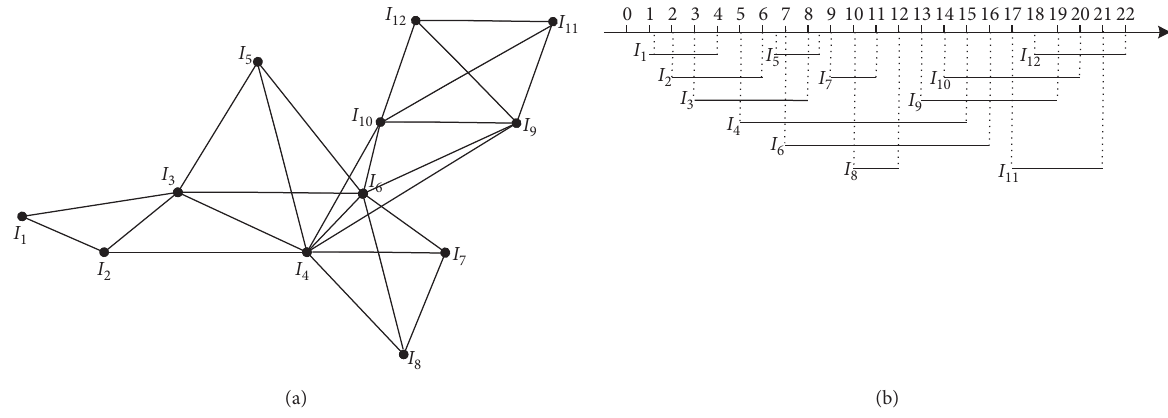
Figure 1: An interval graph G and its interval